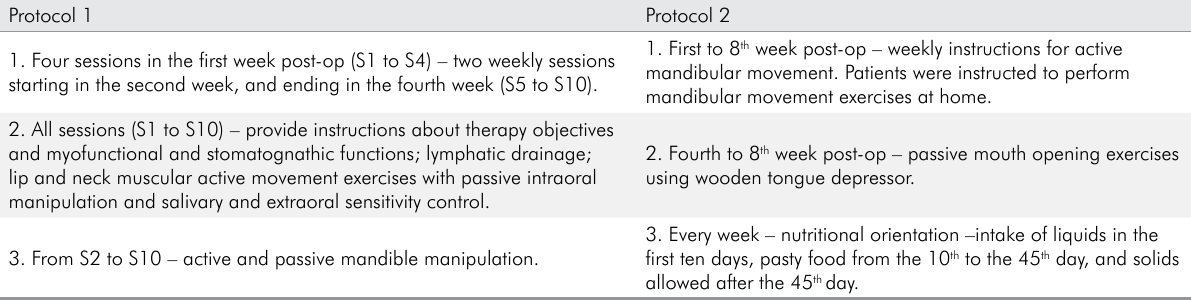
Table 1. Myofunction rehabilitation